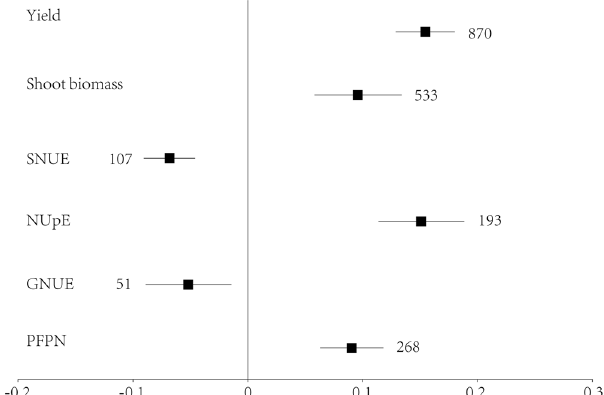
Figure 1. Effect sizes of yield, shoot biomass, shoot N utilization efficiency (SNUE), N uptake efficiency (NUpE), grain N utilization efficiency (GNUE) and partial factor productivity of N (PFPN). Error bars represent 95% bootstrapped confidence intervals (CIs). The effects of genetic transformations were considered significant if the 95% CI of the effect size did not overlap with zero. The number of observations for each category are shown next to the error